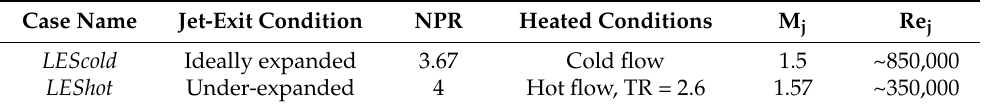
Table 2. LES case nomenclature.